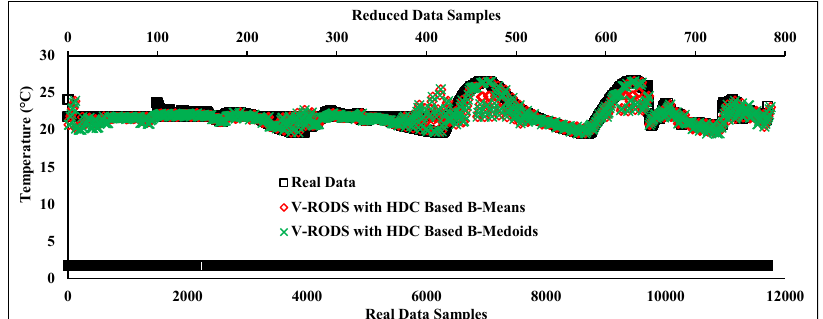
Figure 17. Performance comparison of real noisy data with reduced data using the proposed V-RODS with HDC-based technique versus